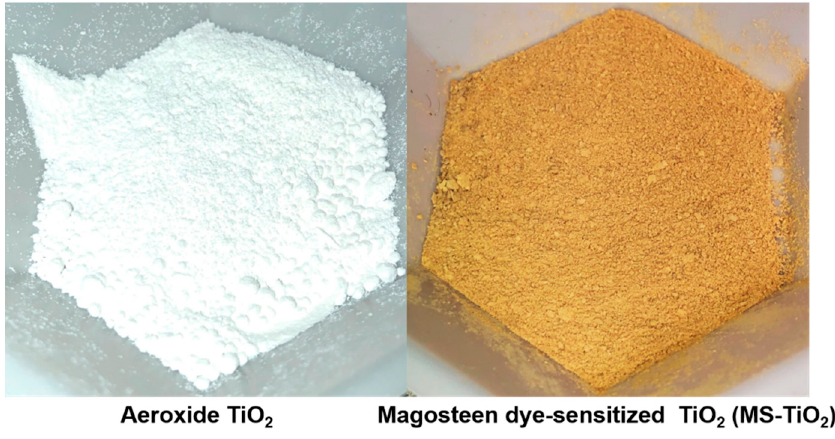
Figure 8. Aeroxide TiO 2 (left) and mangosteen dye-sensitized TiO 2 (MS-TiO 2 ) (right).